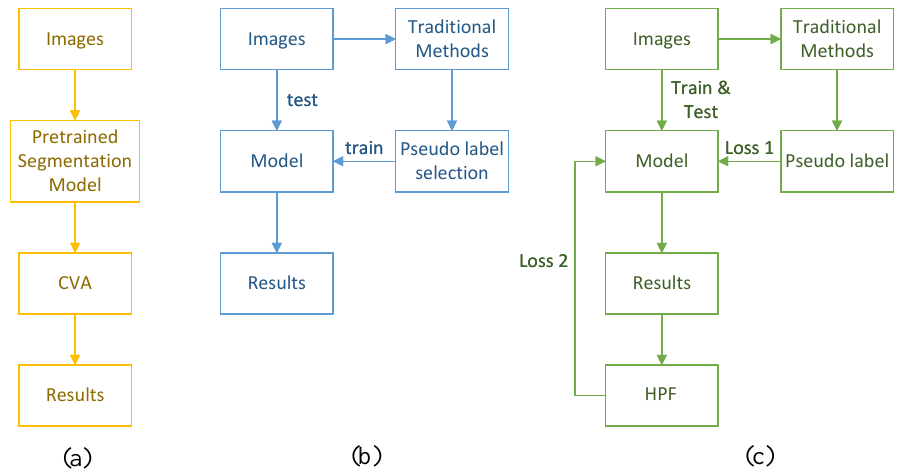
Figure 1. The three frameworks of the unsupervised change detection method using deep learning. ( a ) Pretrained model and change vector analysis [13]. ( b ) Using pseudo label selection for